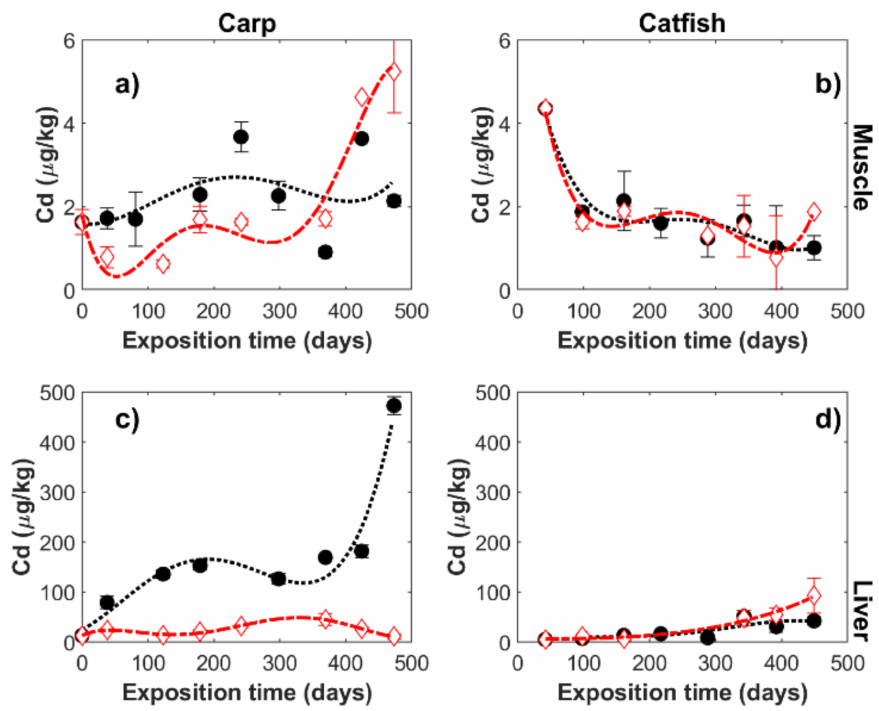
Figure 4. Cd accumulation in the experimental ( • ) and control groups ( carp, ( b ) muscle in catfish, ( c ) liver in carp, and ( d ) liver in